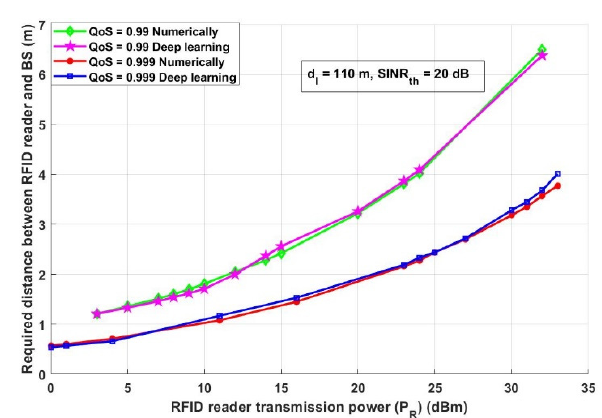
Figure 9. Required QoS versus required distance between an RFID reader and BS (m).